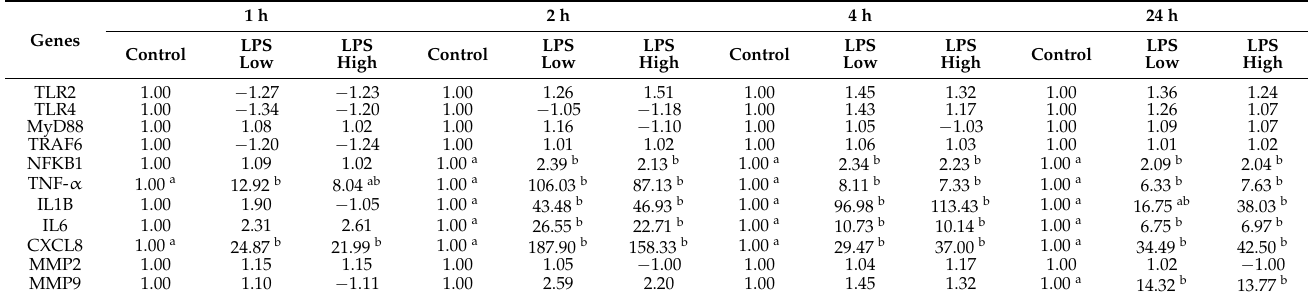
Table 1. Expression of measured genes of REC treated with medium only (Control), LPS low (1 µ g/mL), and LPS high (10 µ g/mL) for 1, 2, 4, and 24 h. n = 5 independent experiments. Values are fold changes expressed relative to the untreated cells (Control). Control was set to 1.0.